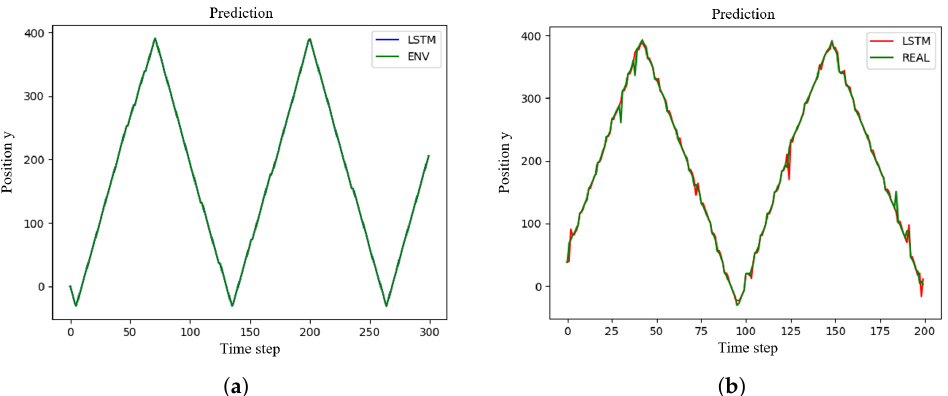
Figure 13. LSTM prediction results in simulation and experiment. ( a ) Simulation environment. ( b )